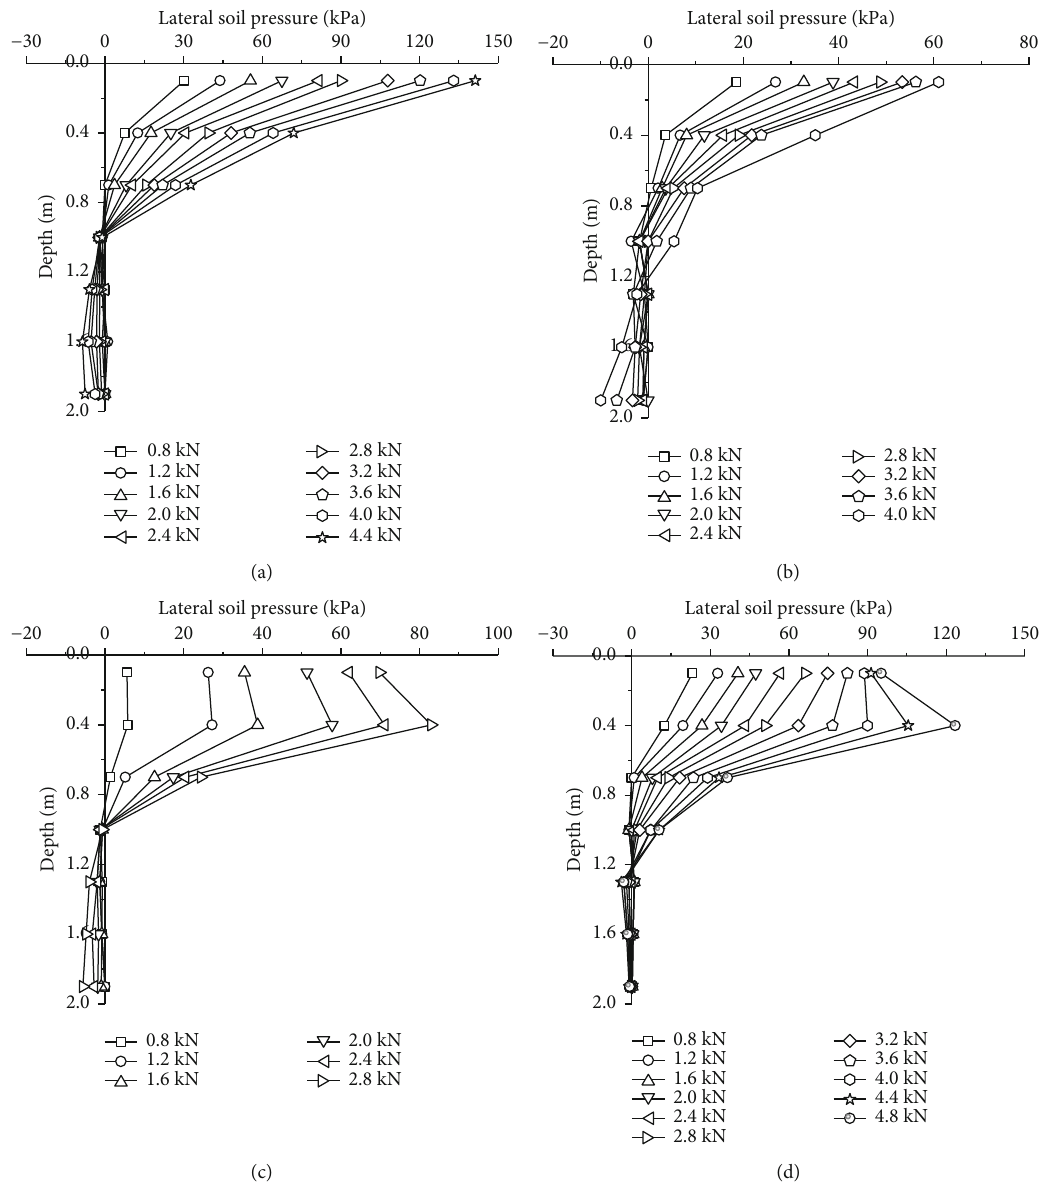
Figure 12: Lateral soil pressure along the pile: (a) Y